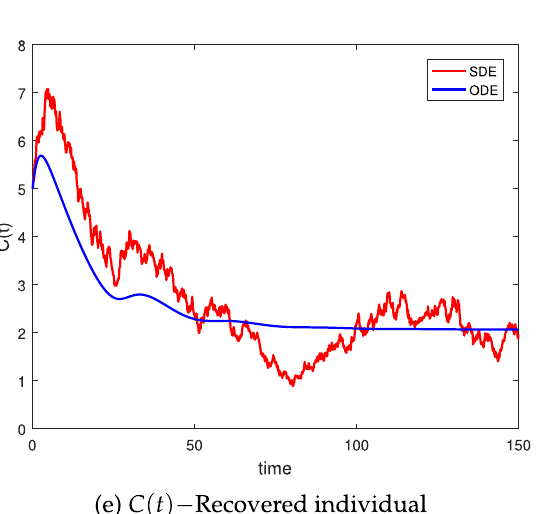
Figure 3. Simulations of ( H ( t ), V ( t ), U ( t ), A ( t ), C ( t )) for the stochastic models (1) with its corresponding deterministic